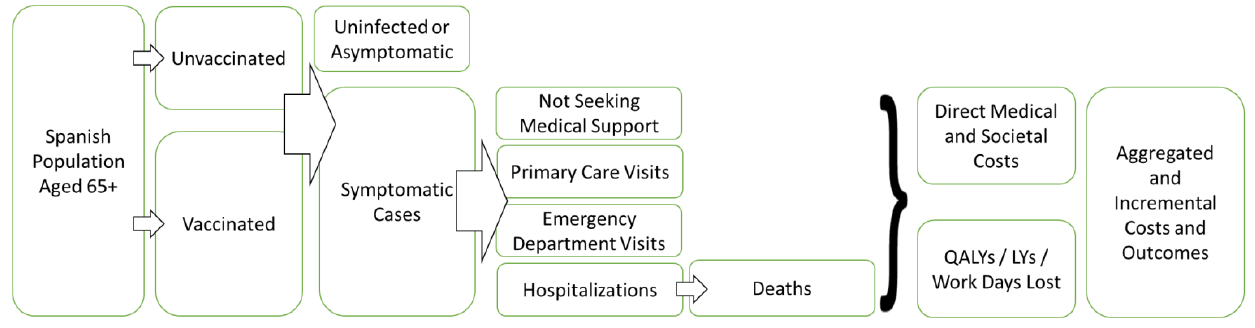
Figure 1. Schematic of the health-economic model. Abbreviations: LYs = life years; QALYs = quality- adjusted life years.